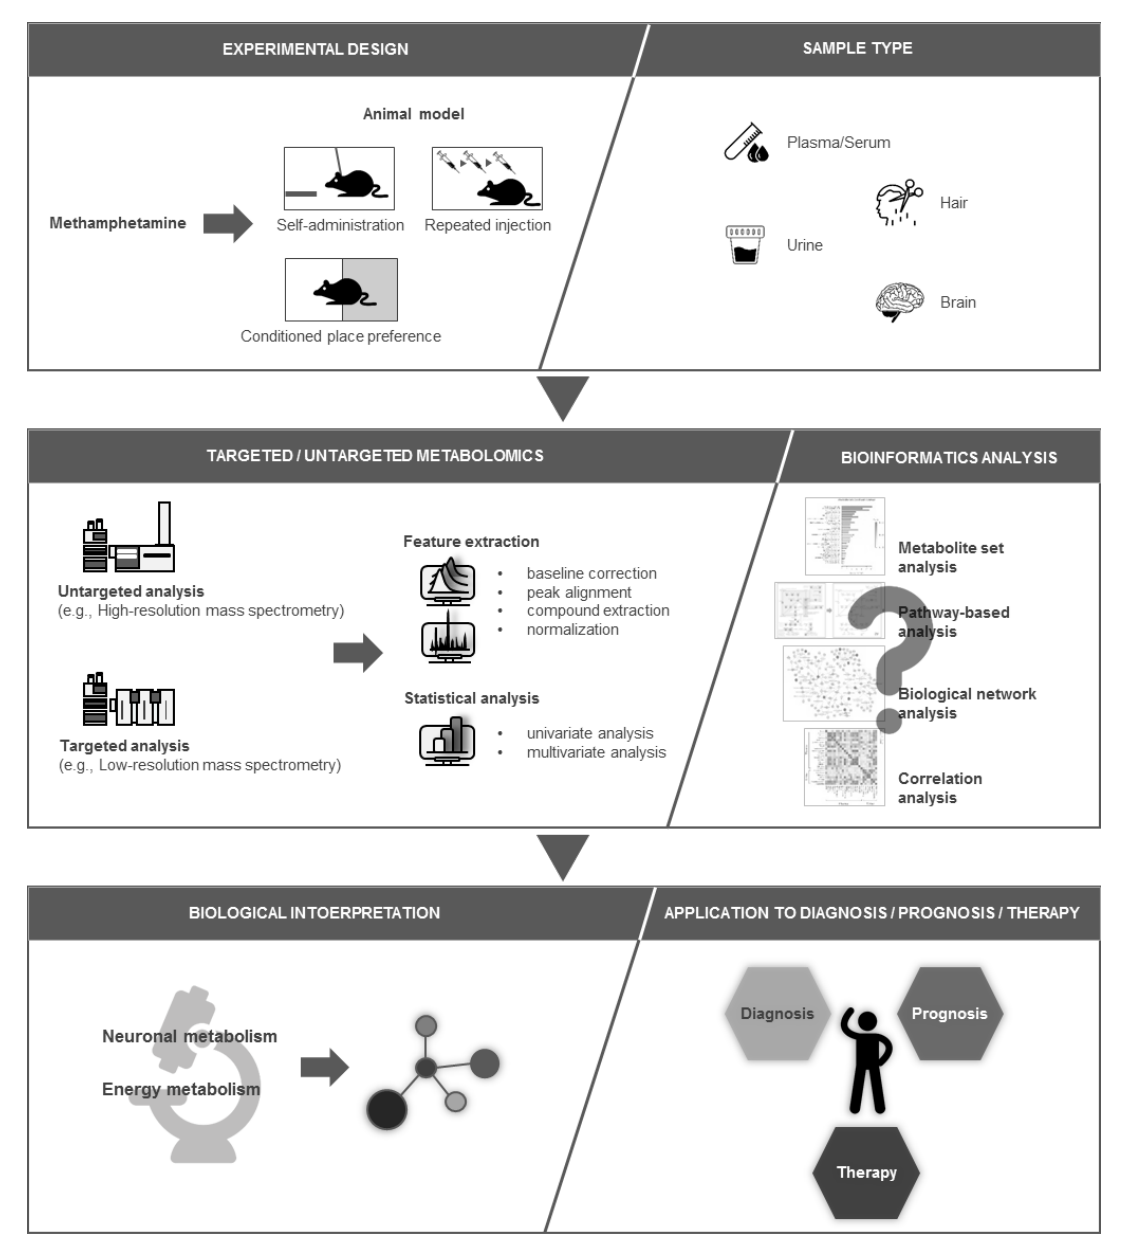
Figure 5. Application of metabolomics in methamphetamine addiction research.